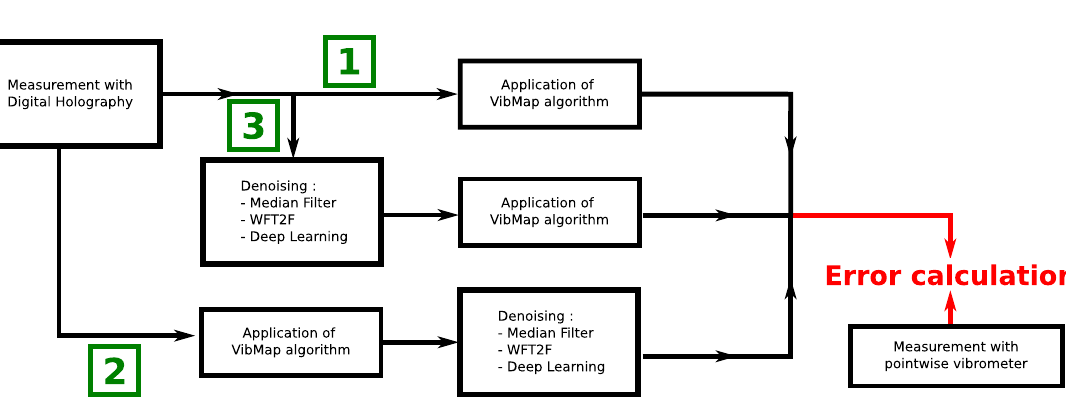
Figure 9. Three schemes for the error evaluation from experimental data, green numbers 1, 2, 3 indicate the three ways for the data